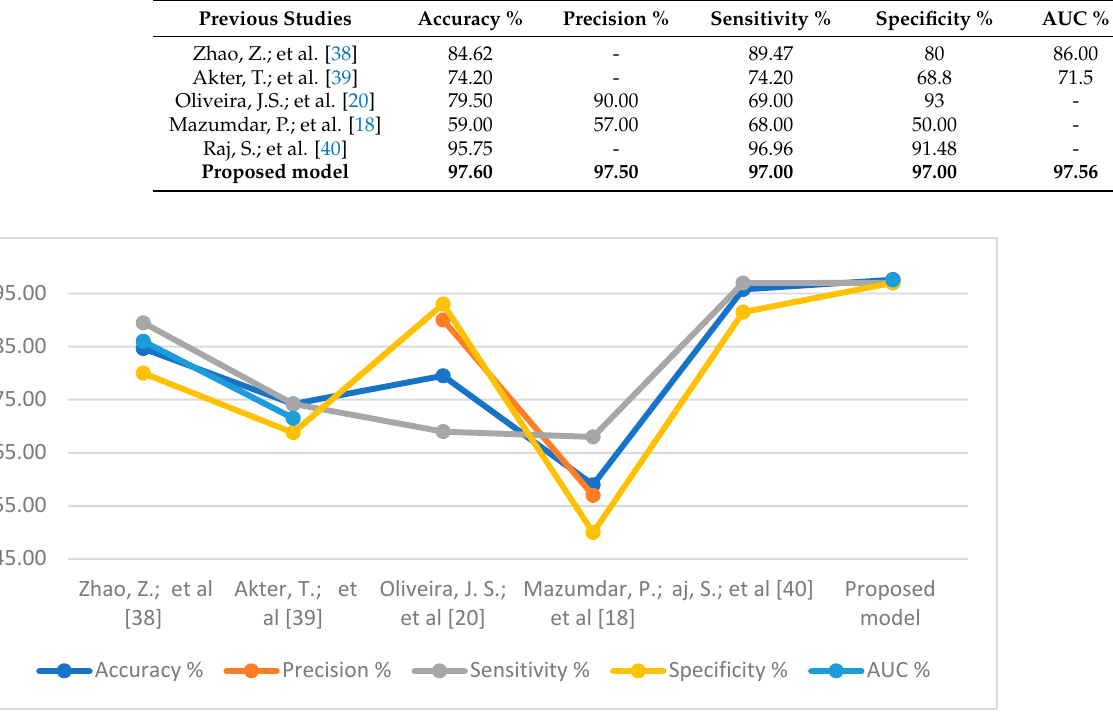
Figure 22. Display comparison between the performance of the previous systems and our proposed system.